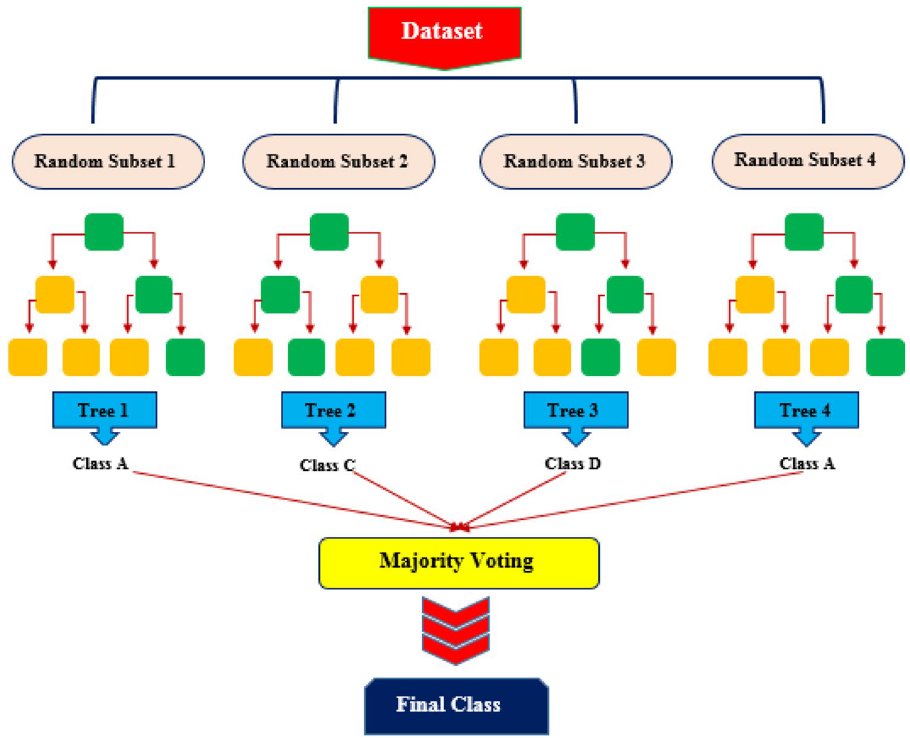
Figure 1. Schematic illustration of random forest